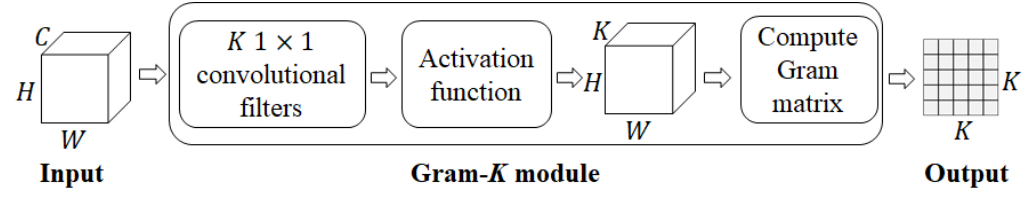
Figure 4. A Gram- K